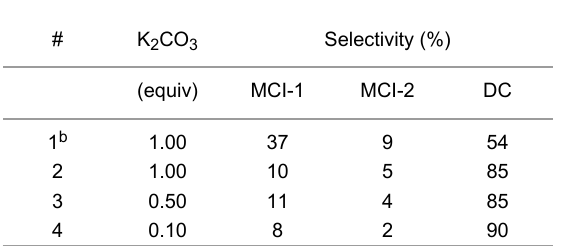
Table 3: Synthesis of dicarboxymethyl isosorbide (DCI) by DMC chemistry.